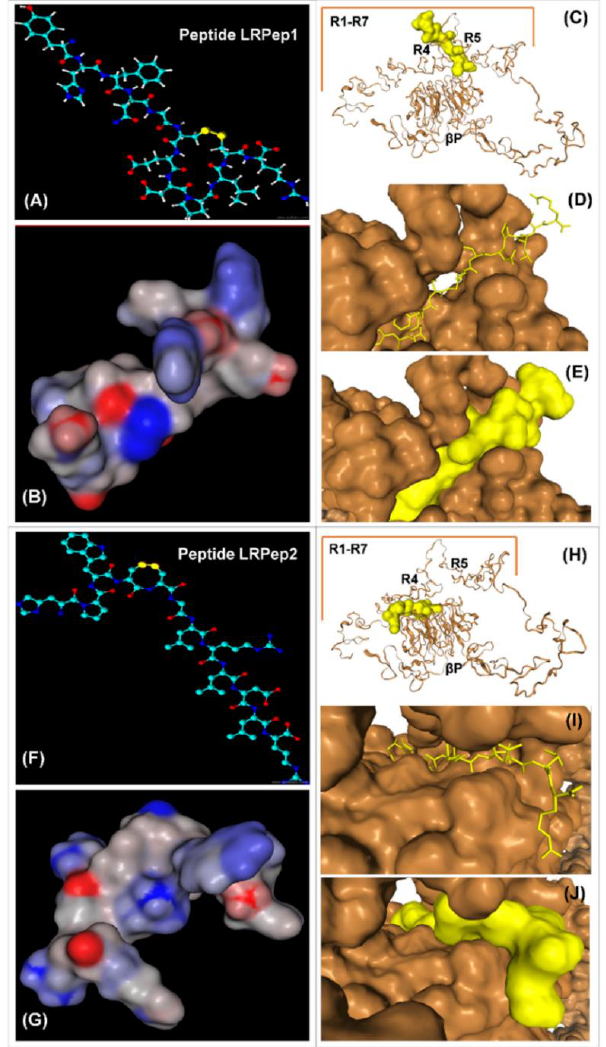
Figure 3. Computational three-dimensional structure ( A , F ) and spatial conformation ( B , G ) of peptides LRPep1 ( A , B ) and LRPep2 ( F , G ). The three-dimensional structures of peptides were drawn with ACD/ChemSketch 2.0 software. The peptides are represented with disulfide bridges that could occur in oxidizing conditions between the pairs of Cys (in yellow in A and F). Their spatial conformations were obtained with MarvinSketch 19.2 software (2019, http://www.chemaxon.com). Interaction of LRPep1 ( C – E ) and LRPep2 ( H – J ) with ED-LDLR was predicted using the HPEPDOCK program of blind peptide-protein docking (http://huanglab.phys.hust.edu.cn/hpepdock/) [16]. The binding regions of peptides to ED-LDLR are zoomed-in figures D – E (LRPep1) and I – J (LRPep2) to better observe the docking models. LRPep1 and LRPep2 appear in yellow, and ED-LDLR in orange. LRPep, LDL